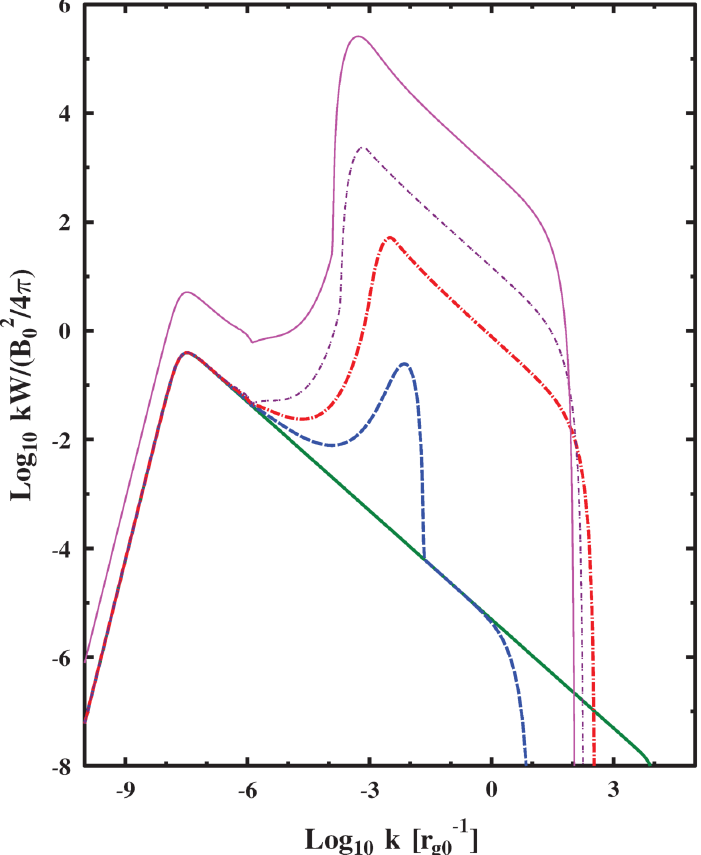
Figure 9. Spectral turbulent energy density for the model A1. The green solid curve corresponds to the point x = x FEB . The blue dashed curve corresponds to the point x ≈ 0.75 · x FEB . The red dash-point curve corresponds to the point x ≈ 0.5 · x FEB . The thin purple dashed curve corresponds to the point x ≈ 0.1 · x FEB . The thin magenta solid curve corresponds to the point x = 0 (the shock front).